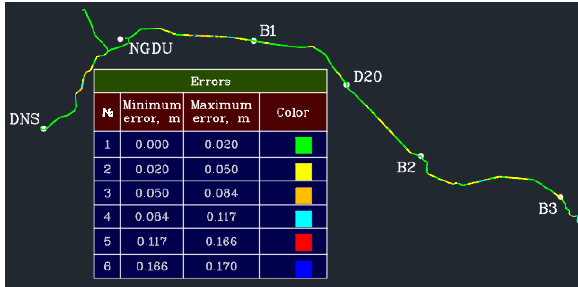
Figure 8. Error distribution for MLS data adjustment using check points every 1 km and control points every 8